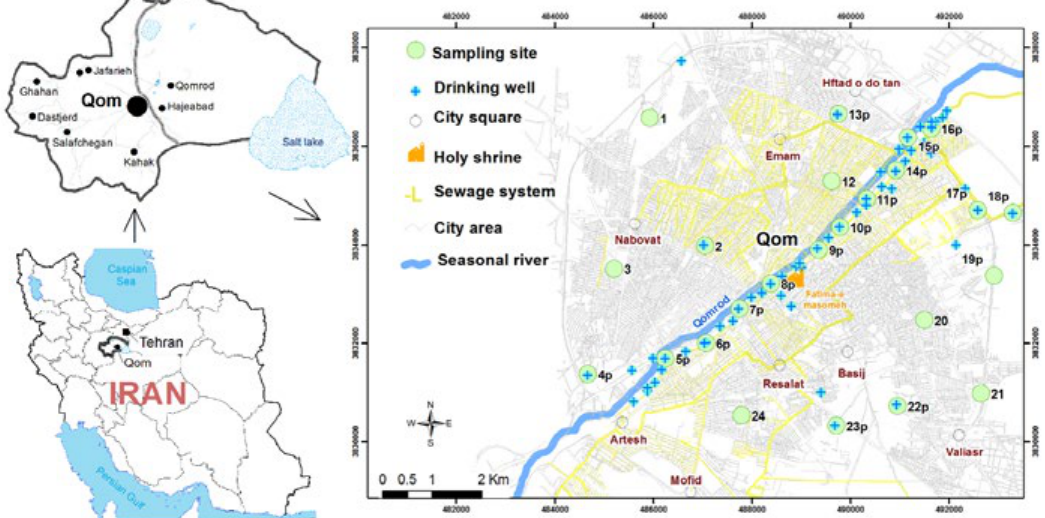
Fig. 1. The study local and